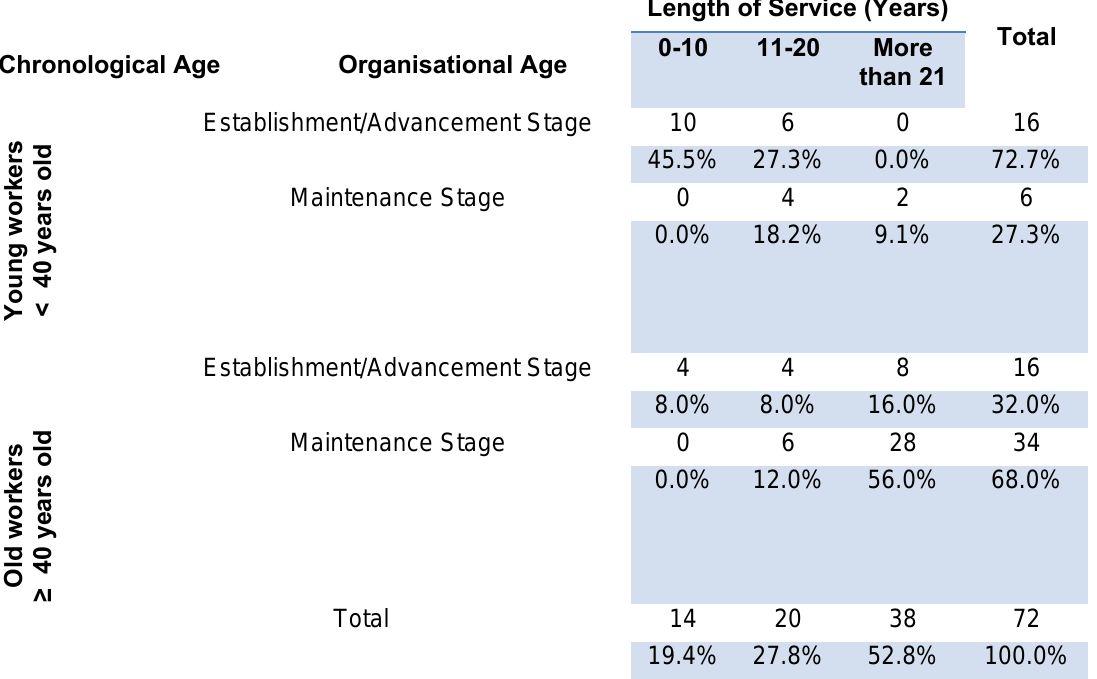
Table 2: Cross-tabulation of respondents’ chronological age, organisational age, and length of